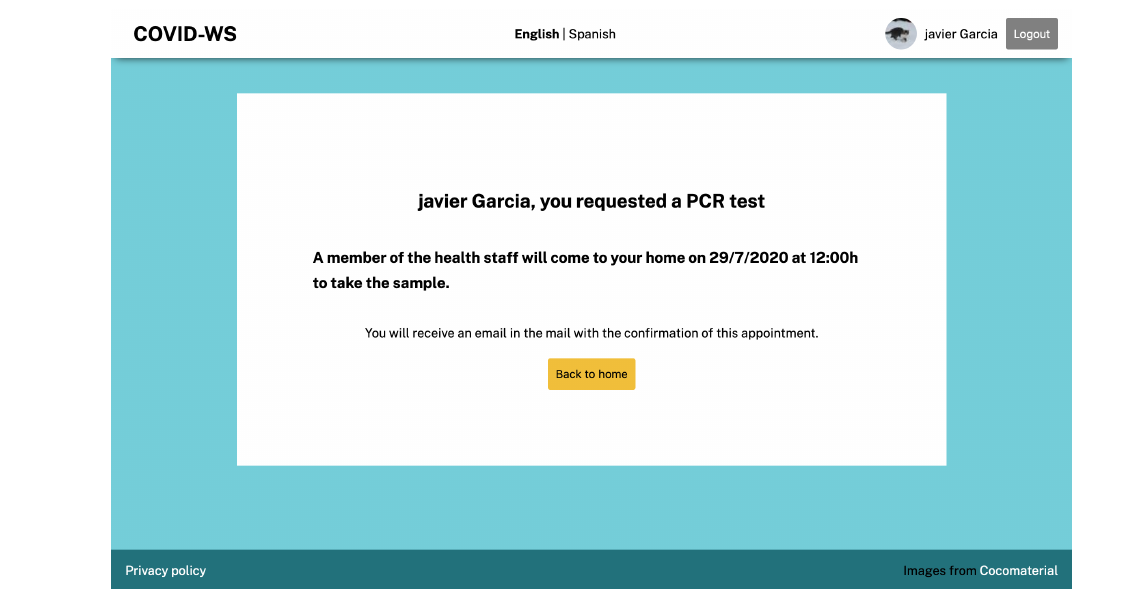
Figure 10. COVID information service confirmation